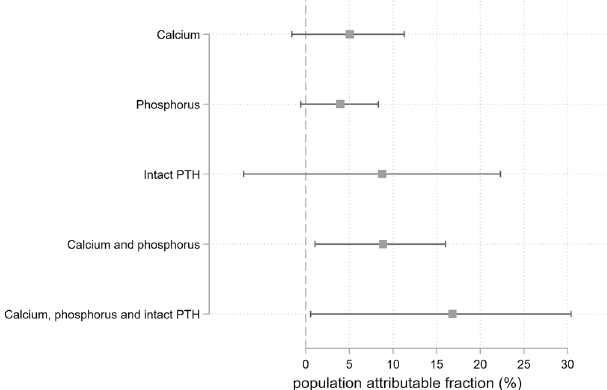
Figure 1. Population-attributable fractions (PAFs) for individual bone-mineral markers and their combinations (pairs). We computed the PAFs for the three bone-mineral markers individually and their combinations (pairs): calcium (8.4–10.0 mg/dL), phosphorus (3.5–6.0 mg/dL), and intact parathyroid hormone (60–240